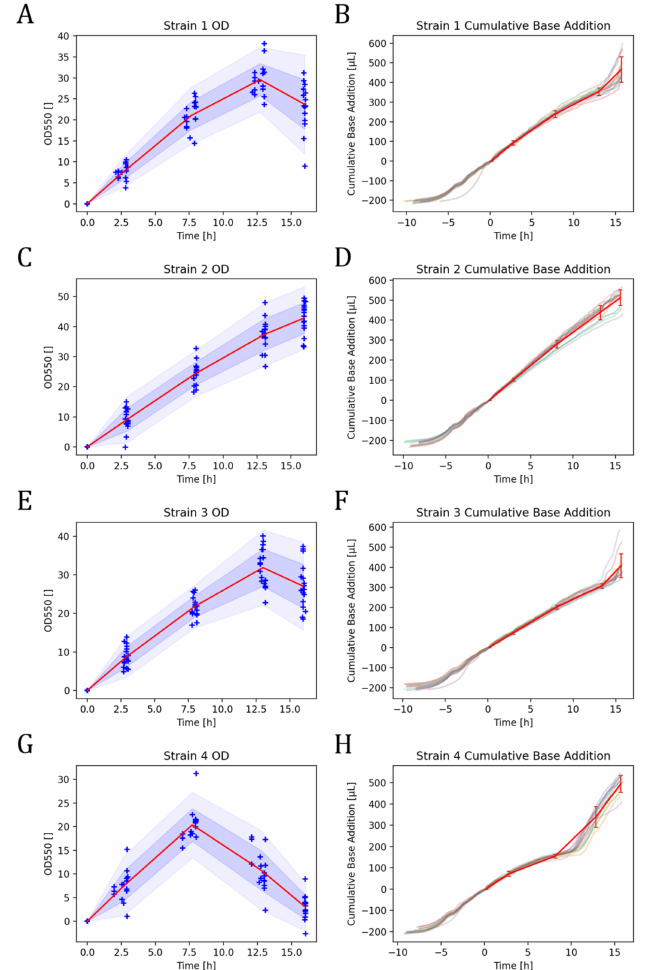
Figure 2. Visualization of the aligned time-series data of the OD and cumulative base addition of the center point experiments of strain 1 ( A , B ), strain 2 ( C , D ), strain 3 ( E , F ) and strain 4 ( G , H ), respectively. For plots ( A , C , E , G ), the area in dark blue indicates the standard deviation and the light blue area the tolerance interval. The mean for all plots is indicated as a red line. Individual measurements are marked by blue plus signs. Table 3. Summary of the normalized standard deviations of the OD and the cumulative base additions of replicate experiments of each strain. The standard deviation at the first measurement is zero, as the data was aligned to start at the origin. In general, the standard deviation of the cumulative base addition increased together with the standard deviation of the